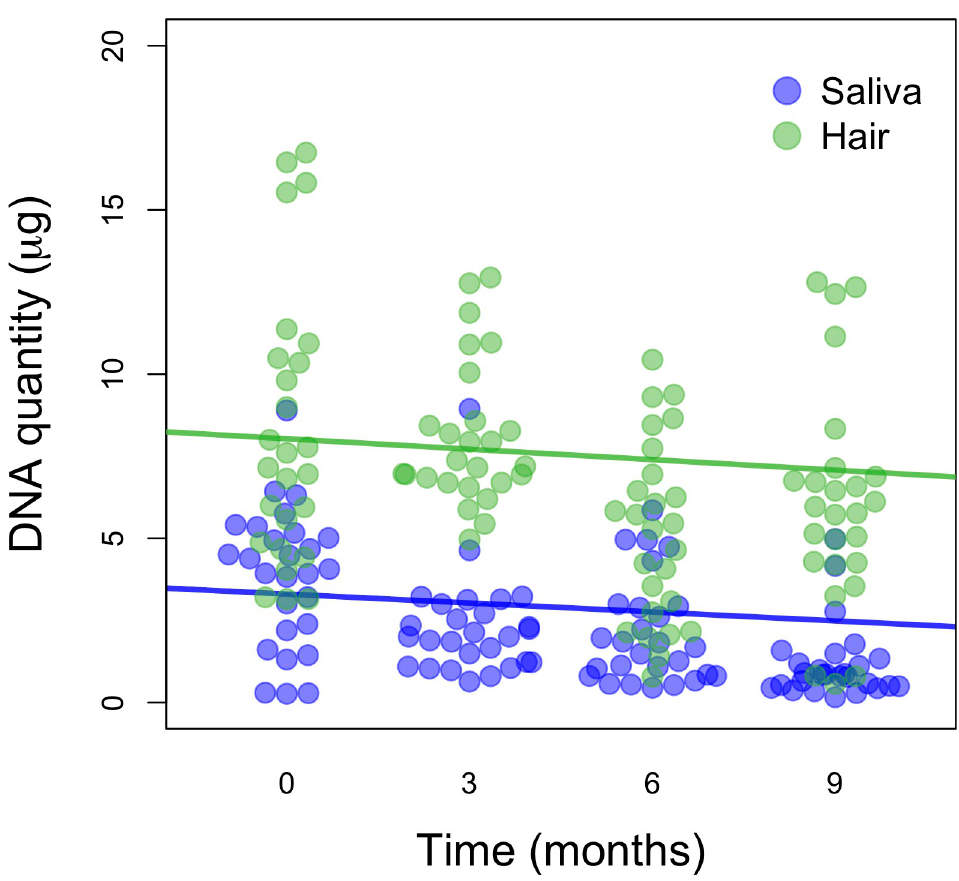
Fig 5. Scatterplot of time vs. extracted DNA amount ( μ g). Samples are separated by DNA source (saliva vs. tail-hair). The amount of DNA is that obtained from the first and second elutions combined (total). Best-fit lines are also shown for each DNA